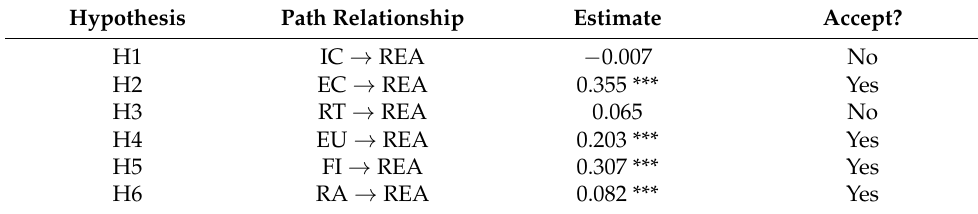
Table 5. Evaluation of study